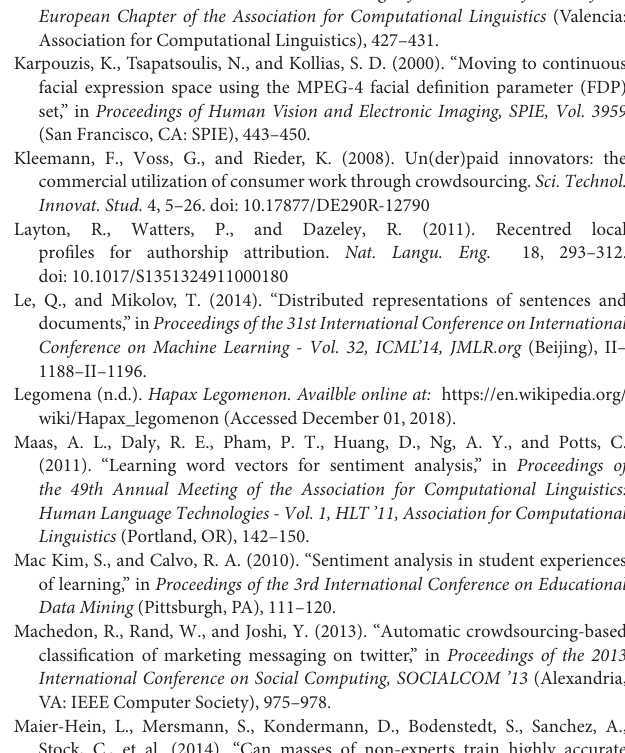
Figure-eight (n.d.). We make ai work in the real world. https://www.figure-eight. com/ (Accessed December 01,